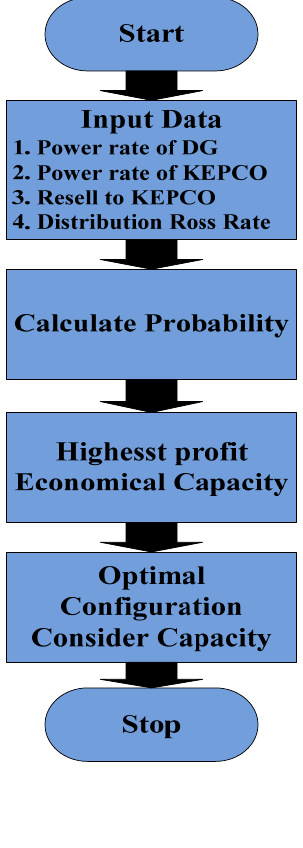
Figure 3. Flow chart of Monte Carlo Simulation.